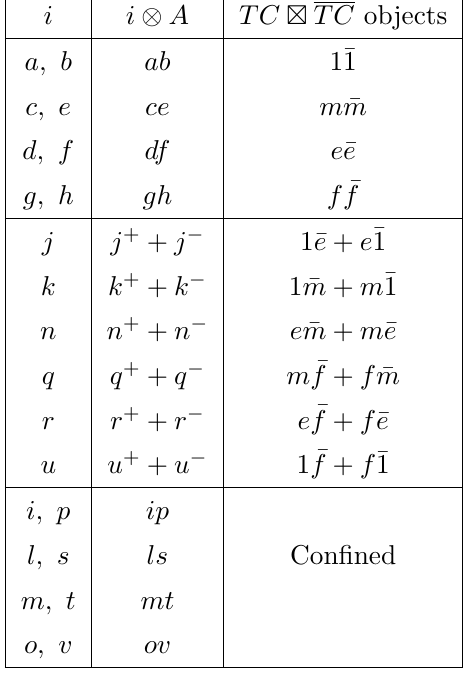
Table 7 . Boson condensation with condensate A = a + b